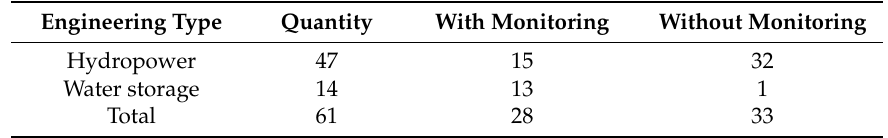
Table 4. Water storage and hydropower projects with ecological flow